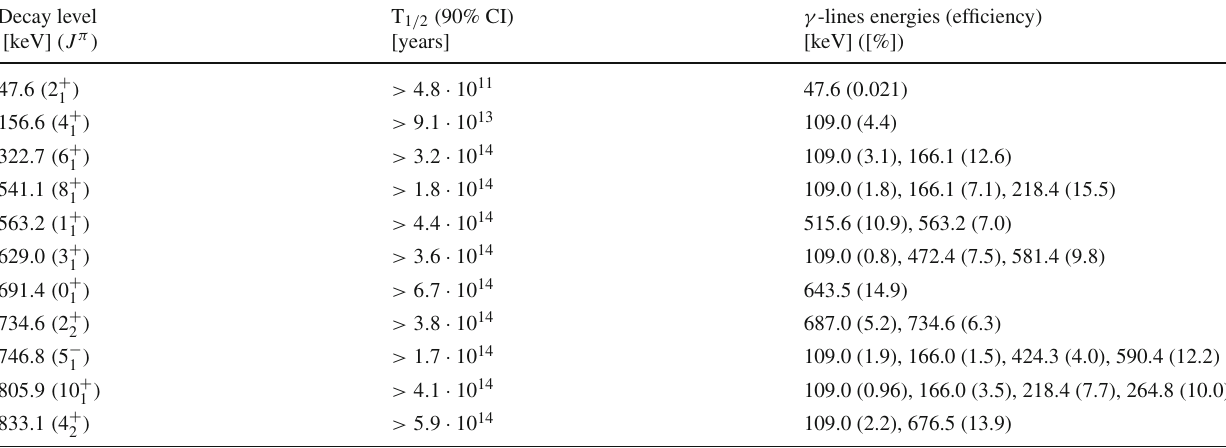
Table 1 Lower half-life limits on 232 Th double beta decay modes set in this work. The last column shows the γ -lines used in the combine fit along with their detection efficiency in the decay